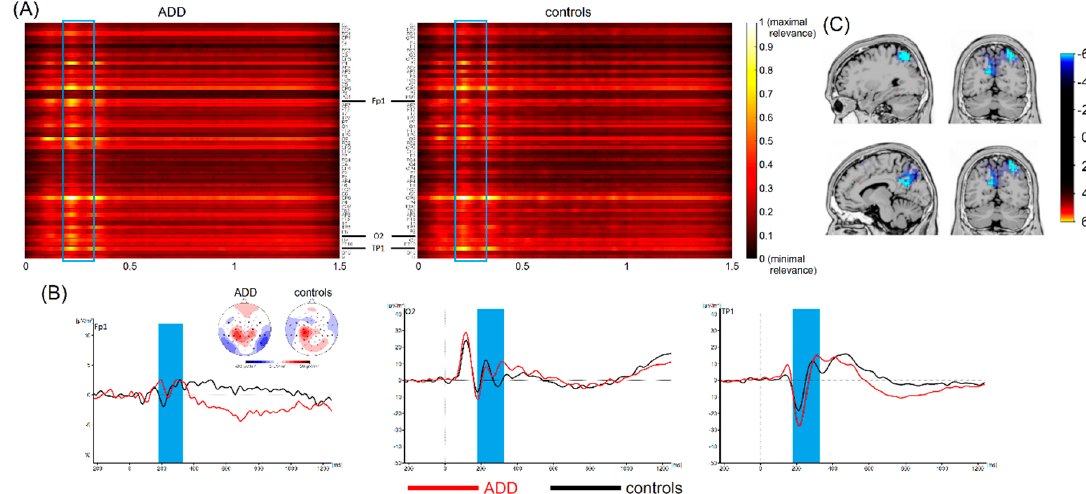
Figure 3. ( A ) Visualization maps showing the relevance of all time points and electrodes for classification between patients with ADD and healthy controls. Values close to 1 indicate that the specific feature at the specific time points contributes most to classification accuracy. The blue frame highlights the most important time range. Based on visual inspection, electrodes Fp1, O2, and TP1 carried the highest relevance. ( B ) Corresponding waveforms (event-related potentials) at the most relevant electrodes are shown with the relevant time range according to the applied machine learning algorithm highlighted in blue. Time point zero denotes stimulus onset in the interval timing task. The black line denotes healthy controls, the red line denotes patients with ADD. Topographic maps show cortical activity in the highlighted time ranges. Blue values denote negativities, red values show positive activations. ( C ) Results of sLORETA source localization show activation in (superior) parietal areas to be different between healthy controls and patients with ADD in the relevant time range.